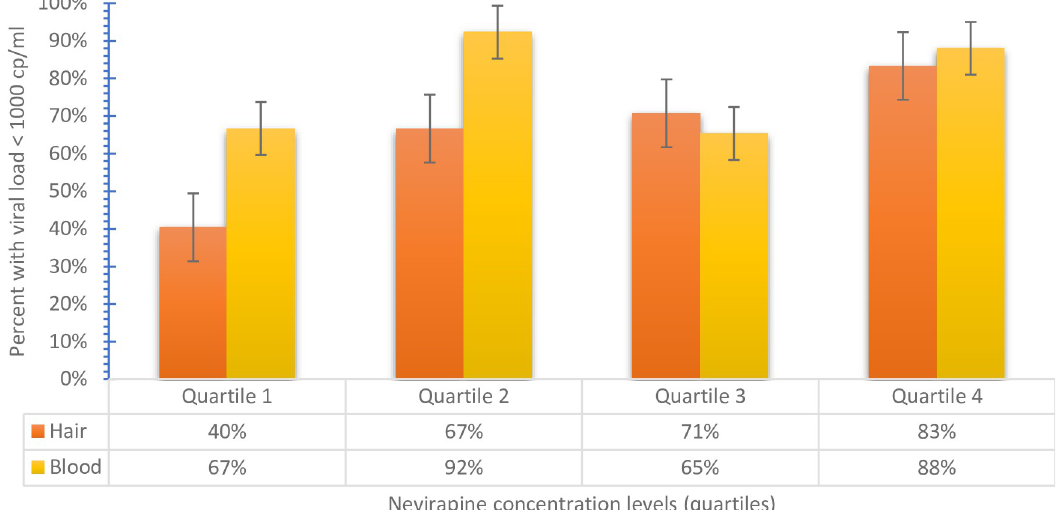
overall median nevirapine concentration in the hair for women with HIV-1RNA load count < 1000 cp/ml in hair was (59 ng/mg (IQR: 23–109 ng/mg) and 19 ng/mg (IQR: 0–73 ng/mg for